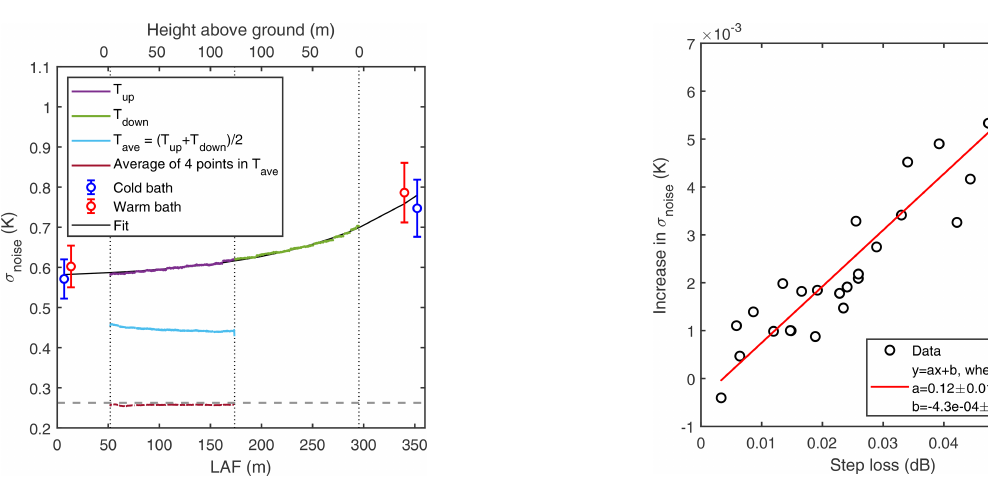
Figure 1. Average dependence of noise (1 σ ), estimated with Eq. (10), for length along the fibre (LAF) and height above ground (top x axis). Circles show T variability in the calibration baths (mean ± SD). Dashed grey line shows the mean T standard devia- tion measured with 3D sonic anemometer at 27m height during the measurement campaign. The vertical dotted black lines show the limits (bottom and top) of the vertical DTS measurements on the mast. The black line is a fit ( σ noise = 0 . 57K + 0 . 01e 8 . 6 × 10 R 2 = 0 . 99) to the noise estimates calculated from the cable going up ( T up ) and down the mast ( T down ). The noise level decreased af- ter averaging the up and down portions of the measurements( T ave ; cyan line) and fell below the typical sonic T variability level further if four spatially consecutive measurements were averaged.